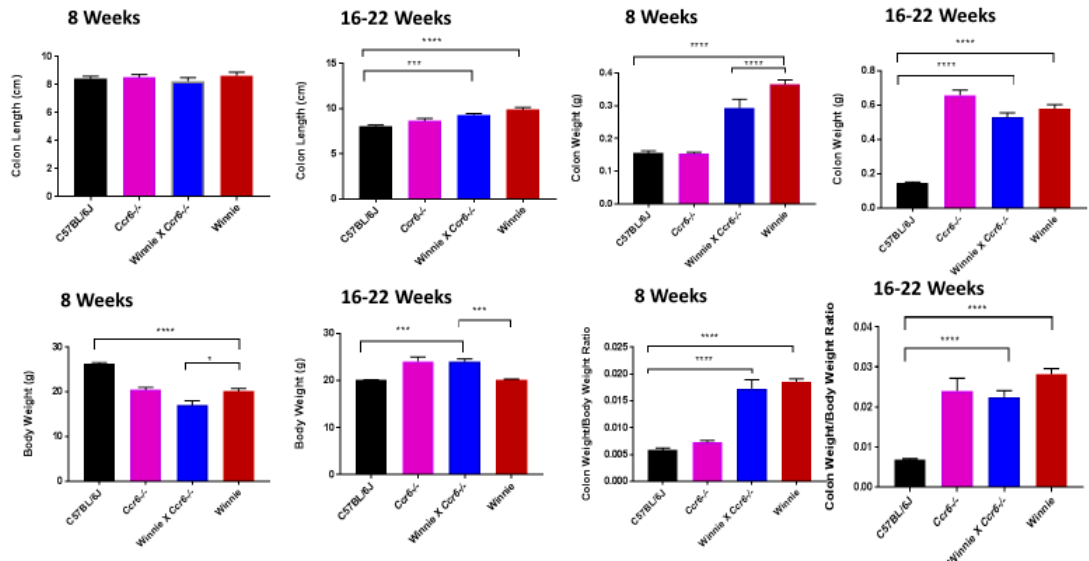
Figure 1. Comparison of the clinical parameters (colon length, colon weight, body weight, colon weight / body weight ratio) of freshly removed colons measured from the ileo-caecal junction to the anus in the four genotypes at 8 weeks and 16–22 weeks of age. Data expressed as Mean ± SEM by one-way analysis of variance (ANOVA) and Tukey’s multiple comparison test, n = 8 per group. ≤ 0.001 (***) and p ≤ 0.0001 (****).